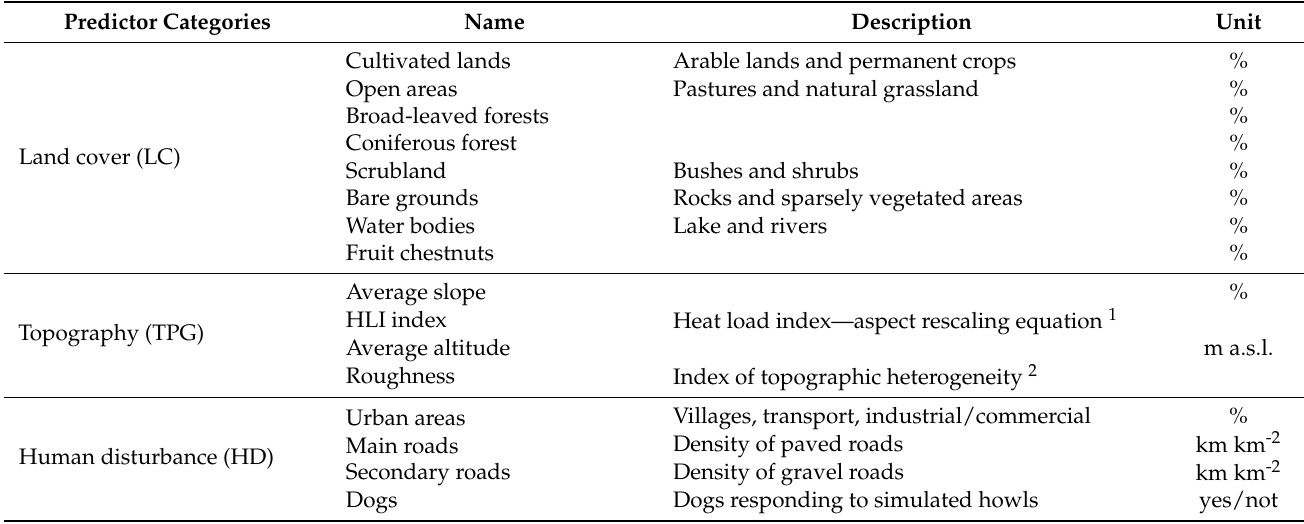
Table 2. List of the tested